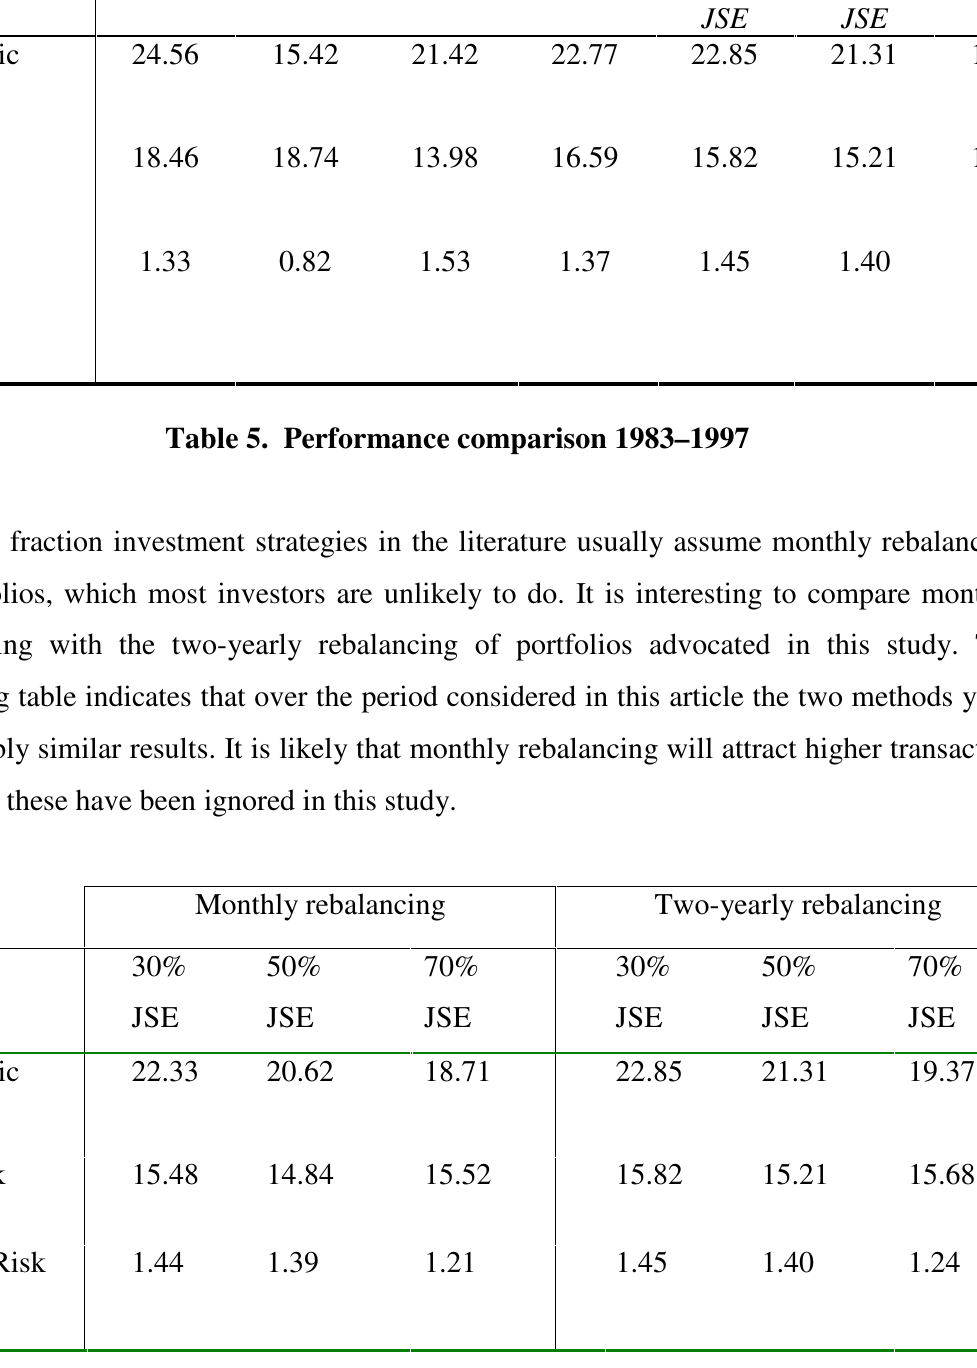
Table 6. Rebalancing of portfolios